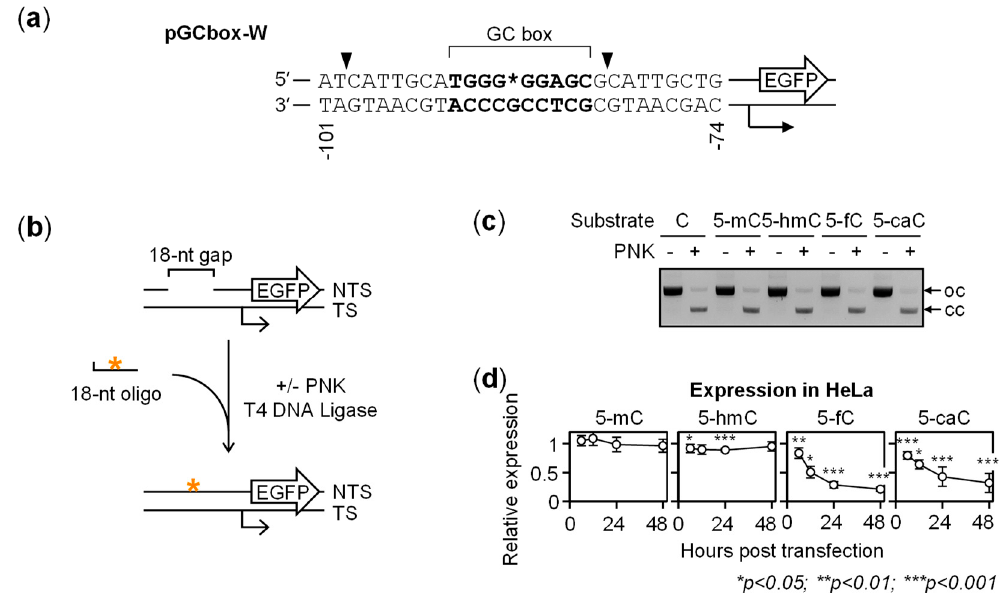
Figure 1. Effects of 5-methylcytosine (5-mC), 5-hydroxymethylcytosine (5-hmC), 5-formylcytosine (5-fC) and 5-carboxycytosine (5-caC) in the purine-rich strand on the GC box activity. ( a ) Scheme of the reporter enhanced green fluorescence protein ( EGFP ) gene under the control of a GC box as the only upstream activating element. Synthetic oligonucleotide containing cytosine modifications at the unique CpG site (position indicated with an asterisk) were incorporated into the gap generated with the Nb.BsrDI nicking endonuclease (cleavage sites indicated with arrowheads). ( b ) Procedure for the incorporation of synthetic oligonucleotides containing C/5-mC/5-hmC/5-fC/5-caC (*) into the gap generated by depletion of the purine-rich strand of the targeted GC box. Aliquots of the same annealing reactions were incubated with or without T4 polynucleotide kinase (PNK) to validate full replacement of the native DNA strand. DNA strand labeling denotes transcribed strand (TS) of the EGFP gene and the non-transcribed strand (NTS); broken arrow indicates the transcription start site and direction. ( c ) Agarose gel electrophoresis of the reporter constructs generated by targeted incorporation of C/5-mC/5-hmC/5-fC/5-caC into plasmid DNA. Arrows indicate the open circular (oc) and covalently closed (cc) forms. ( d ) Expression time course of constructs containing 5-mC/5-hmC/5-fC/5-caC in transfected HeLa cells. All values (mean ± SD) are calculated relative to the expression of the control construct harboring synthetic oligonucleotide containing cytosine for n = 6 independent experiments (the 12-h point was skipped in three of the experiments). Representative flow cytometry data is shown in Supplementary Materials Figure S1.